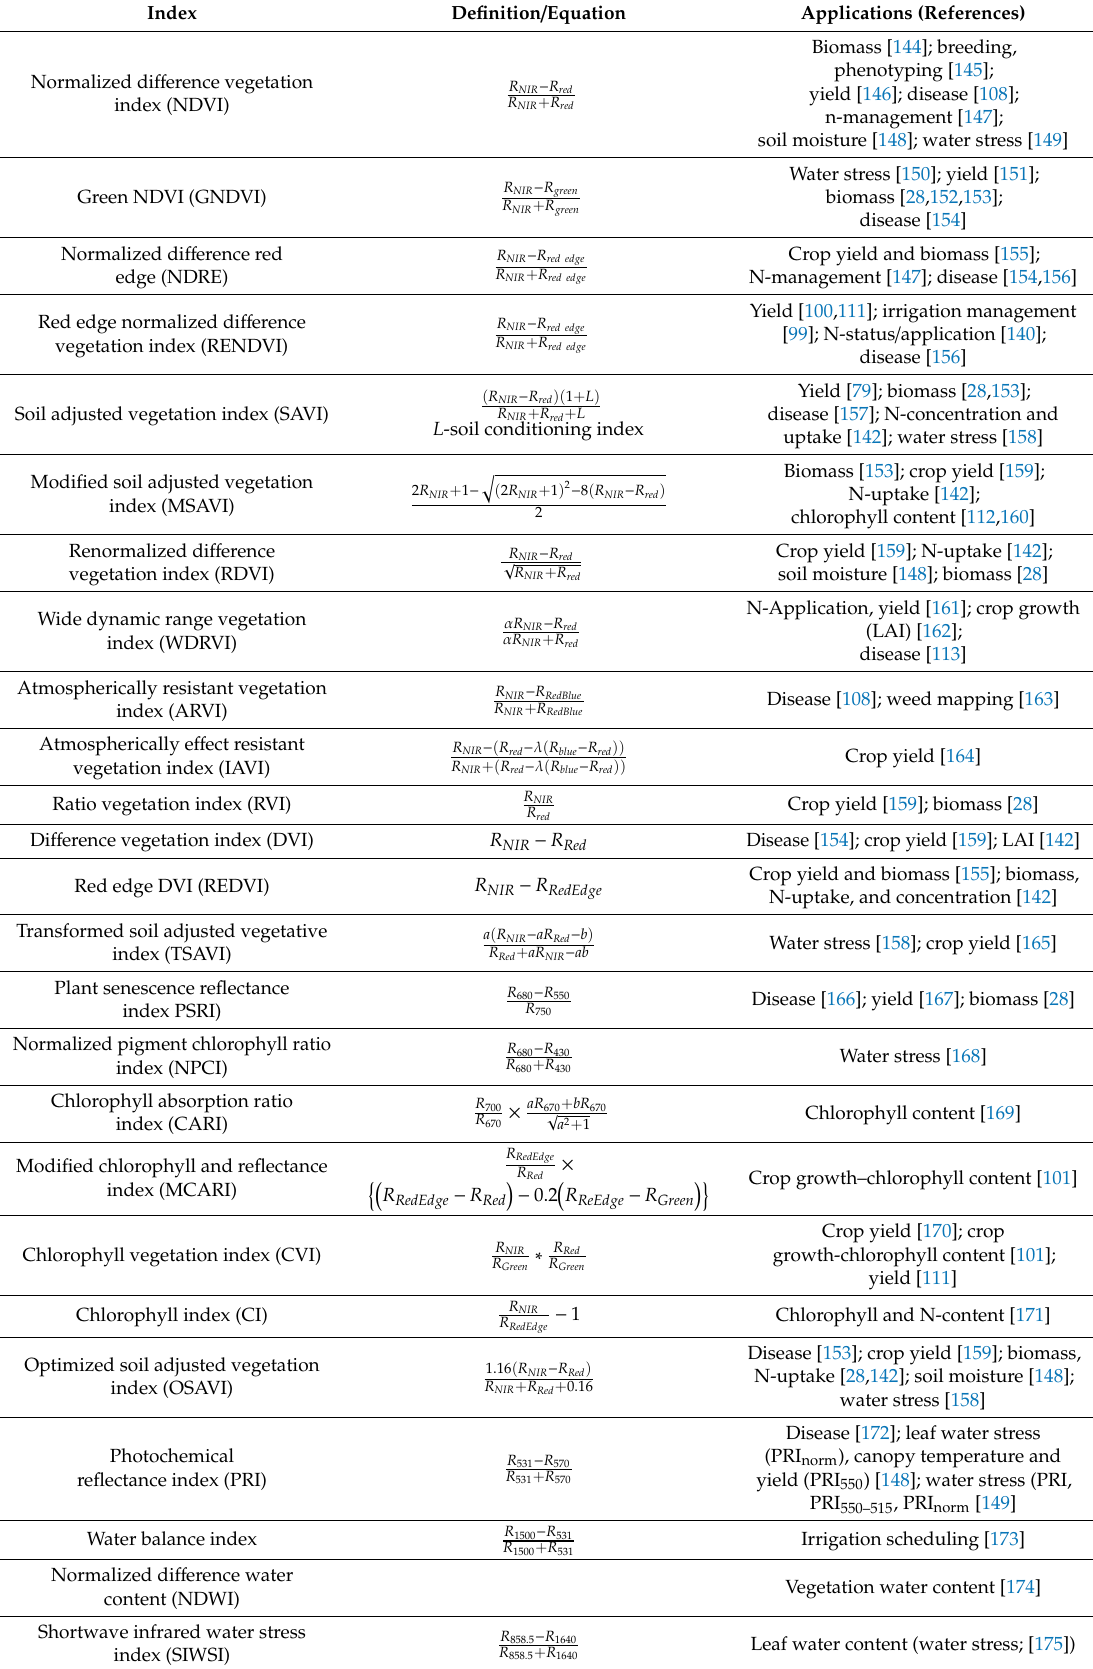
Table 2. Some recently used vegetation indices for remote sensing applications in precision agriculture